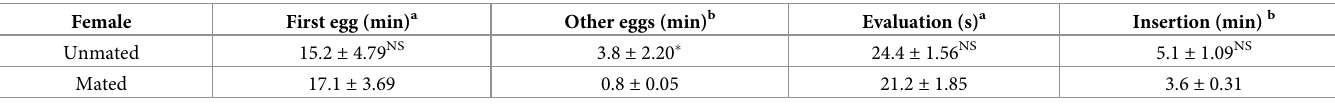
Table 1. Time period (mean ± standard error) to find the first egg, other eggs, time to ovipositor insertion (minutes), and egg evaluation (seconds) by Cleruchoides noackae (Hymenoptera: Mymaridae) female on Thaumastocoris peregrinus (Hemiptera: Thaumastocoridae) eggs.